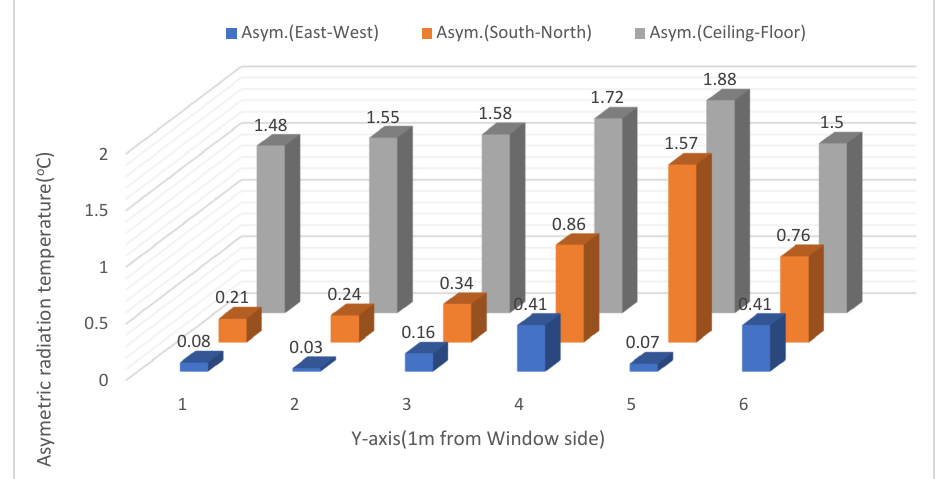
Figure 10. Asymmetric radiation (7 August, p.m. 12:51). The maximum asymmetric radiation (1.88 °C) is raised at y5 (the ceiling and floor on the window side). Asymmetric radiation does not happen in this radiant cooling space because the floor’s radiant cooling surface radiates to the surrounding surfaces mostly by the radiation. The highest radiant asymmetry is 1.88 °C near the south window side. Local